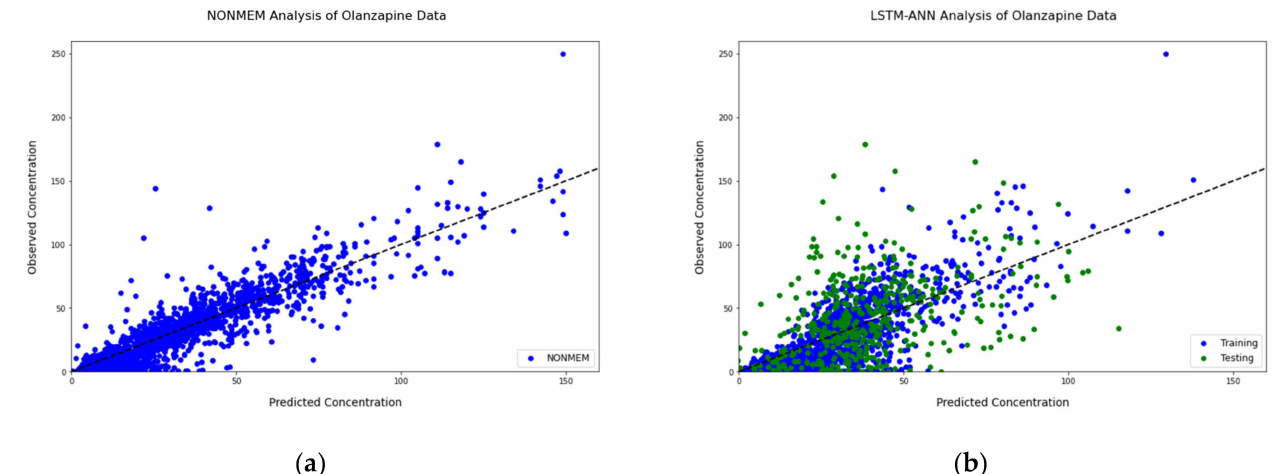
Figure 4. Observations vs. Predictions plot. ( a ) NONMEM (note: predictions are individual predictions (IPRED]); ( b ) LSTM-ANN (The different colors correspond to drug concentration predictions from the different datasets. Blue represents the training data, and the green represents the validation